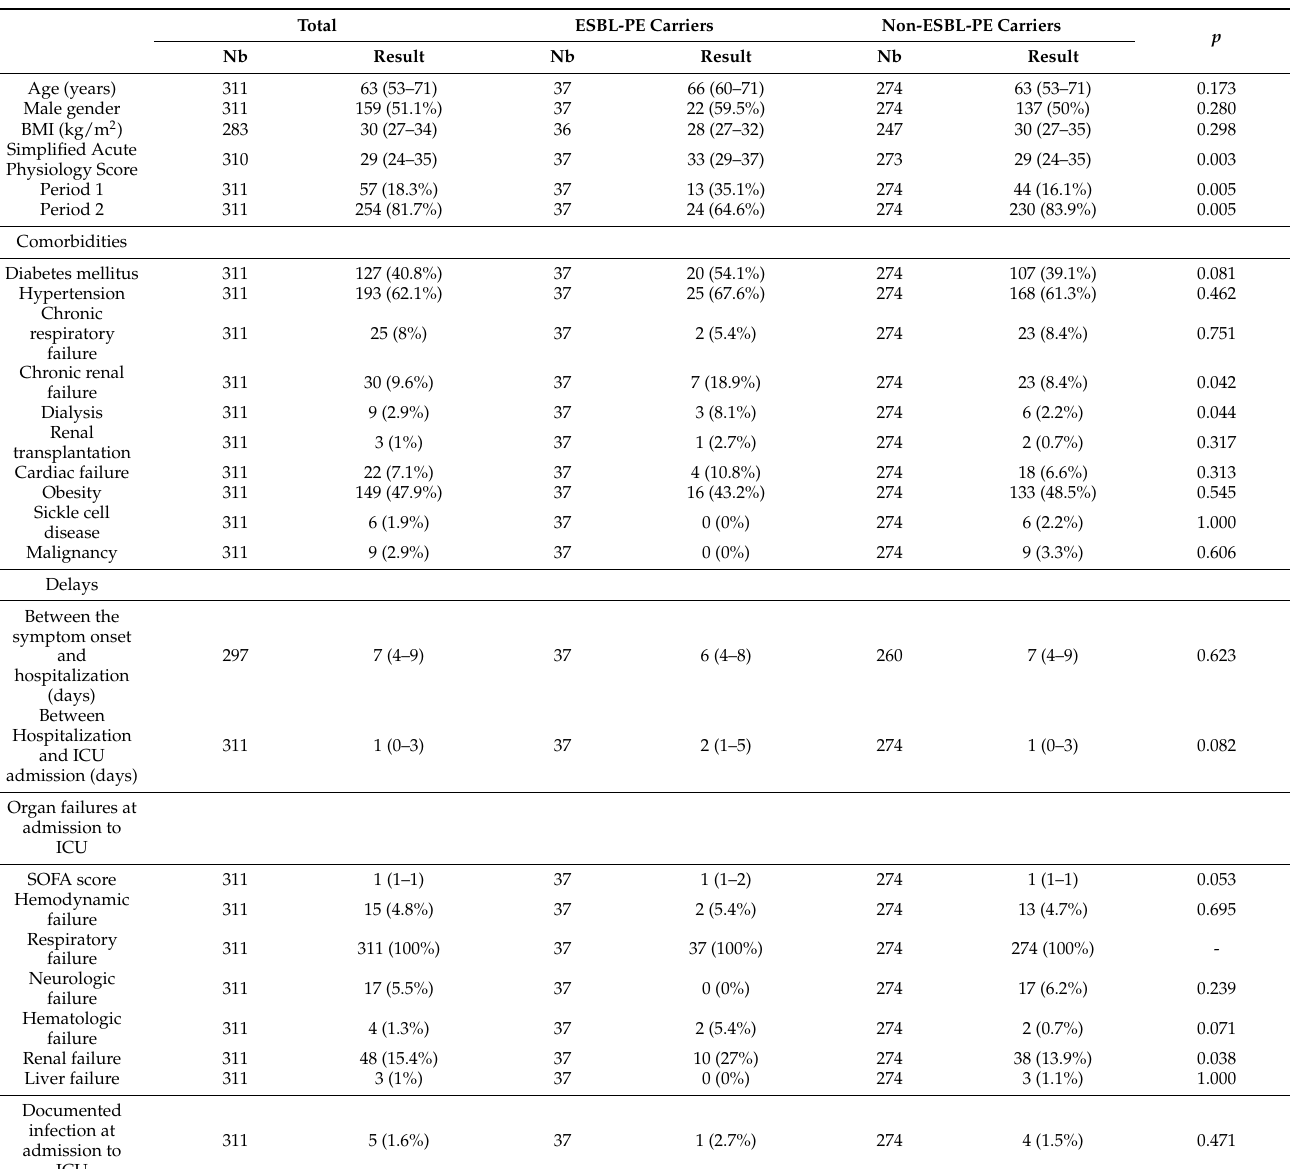
Table 1. Epidemiologic and clinical parameters recorded upon admission to ICU.